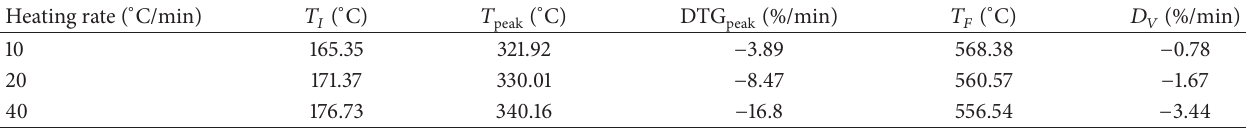
Table 3: Results from thermogravimetric analysis in N 2 atmosphere with different heating